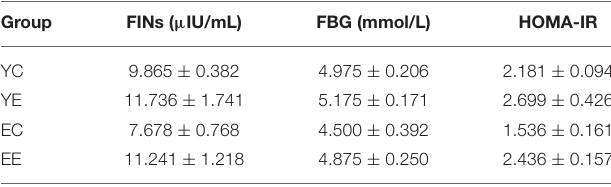
TABLE 3 | Descriptive statistics of serum concentrations of FINs and FBG, and HOMA-IR in 40